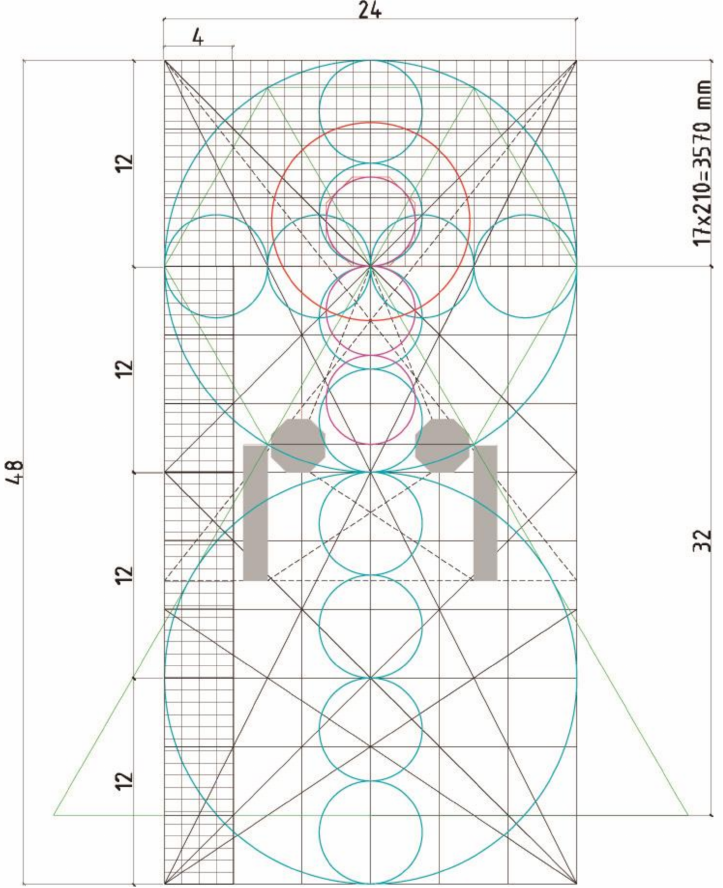
Figure 16. The unusual proportions of the Seokguram temple. Its floor plan can be exactly tessellated with 1632 DIN A4